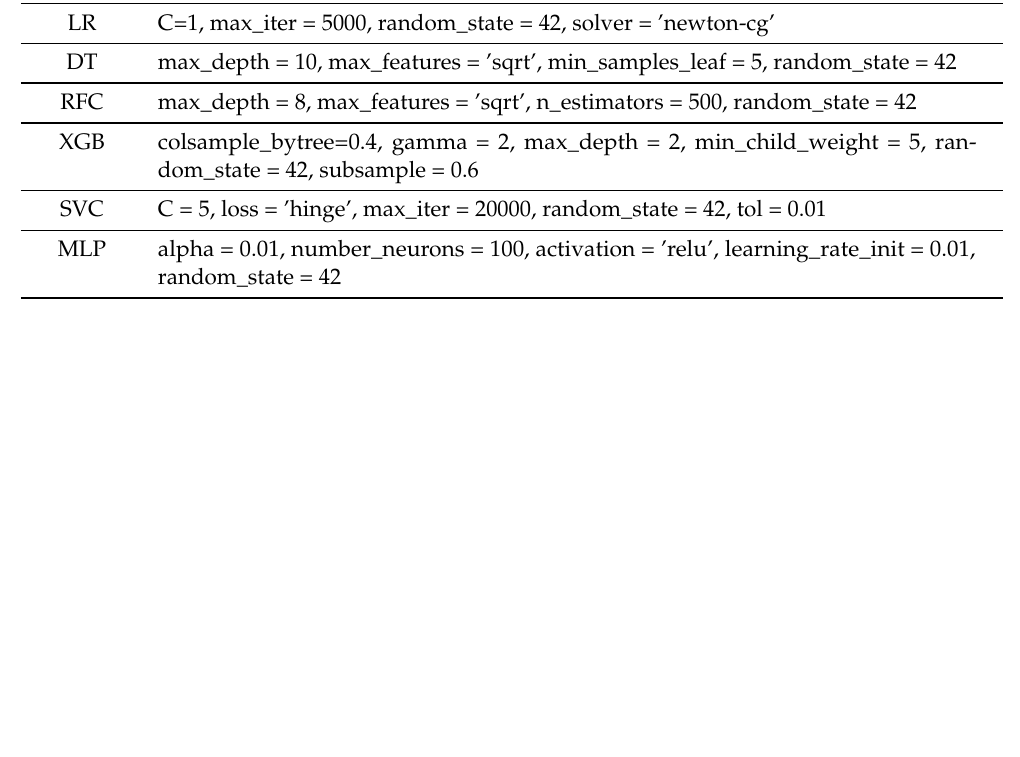
Table A1. Model Parameters. Algorithm